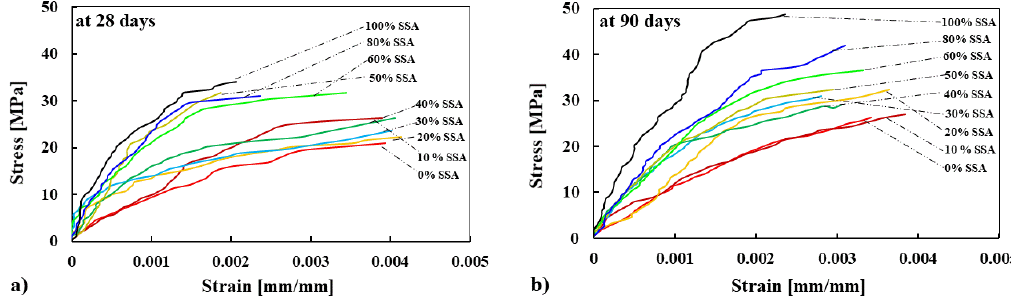
Figure 6. Stress–strain curves of concrete made with SSA measured at 28 days ( a ) and 90 days ( b ).